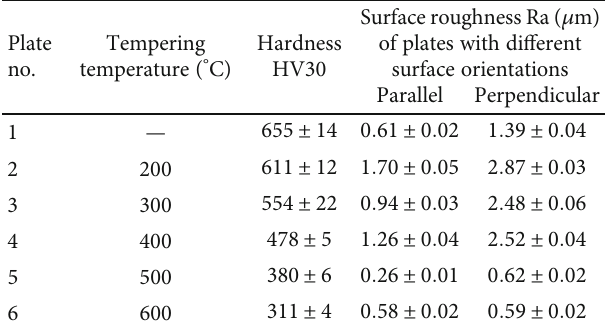
Figure 2: Test stand for measuring the external friction angle of seeds: 1: computer; 2: CPU (central processing unit) converter; 3: stepper motor lifting the arm of the instrument; 4: arm; 5: base of the instrument; 6: friction plate; 7: light receiver; 8: seed; 9: light emitter; 10: LSD display; 11: switch for manually controlling the arm of the instrument; 12: status diode light (on or o ff ); 13: main on/o ff switch. Table 1: Hardness and surface roughness of friction plates ( mean value ± standard deviation